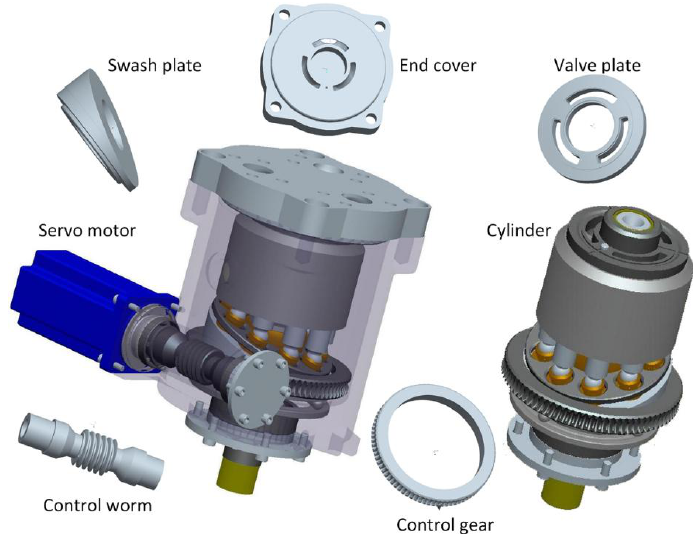
Figure 3. Structure of the swash plate-rotating hydraulic transformer.